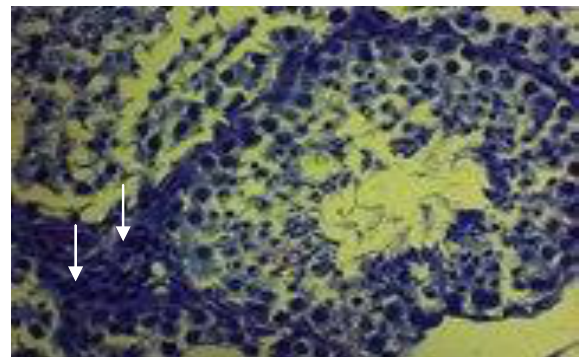
Figure, 3: Leydig cells (arrows) inside interstitial tissue during winter season. PAS X400.